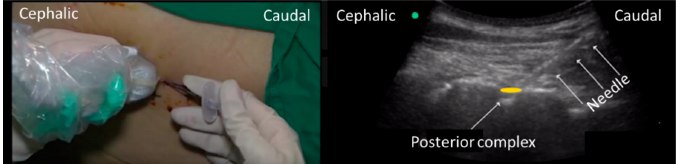
Figure 2. Example of how to hold the probe ( left the probe was firmly held in the marked position by the operator’s left hand. A 18G Tuohy needle from the caudal of the probe was advanced to by the operator’s right hand ). Ultrasound imaging while operating puncture ( right ) THE needle was seen in the ultrasound